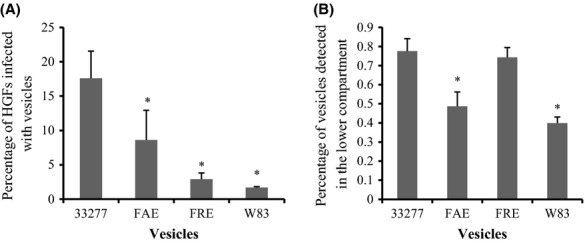
Transepithelial transport of Porphyromonas gingivalis vesicles across a monolayer and invasion of vesicles into human gingival fibroblasts (HGFs) in a transwell culture system. (A) The ability of vesicles derived from 33277, fimA mutant (FAE), fimR mutant (FRE), and an afimbriated strain (W83) to translocate across a monolayer of HOKs was examined using a transwell system and quantitated with enzyme-linked immunosorbent assay (ELISA). Data are shown as means of three independent experiments with standard deviations. An asterisk indicates a significant difference between translocated vesicles of 33277 compared to those with vesicles from other strains (*P < 0.05 by t-test). (B) The percent of HGFs infected by transepithelial vesicles in the wells of a six-well plate is shown. An asterisk indicates a significant difference between the percent of HGFs with internalized vesicles of P. gingivalis strains compared to those with 33277 vesicles (*P < 0.05 by t-test).